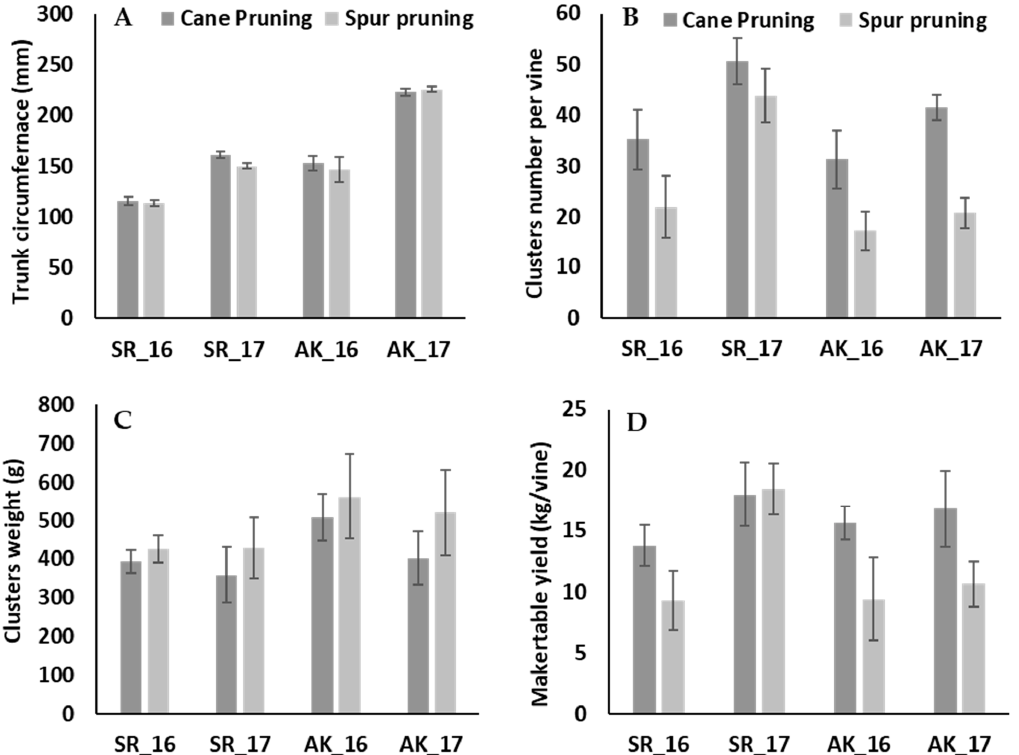
Figure 2. Effect of Head training, cane pruning and Quadrilateral cordon training, spur-pruning systems on Trunk circumference ( A ), cluster number ( B ) and cluster weight ( C ), and marketable yield ( D ) of Scarlet Royal (SR) and Autumn king (AK) table grapes during 2016 and 2017 seasons. ANOVA statistical analysis was used to measure the differences among treatments at a 0.05 significance level. Error bars represent the standard deviation.